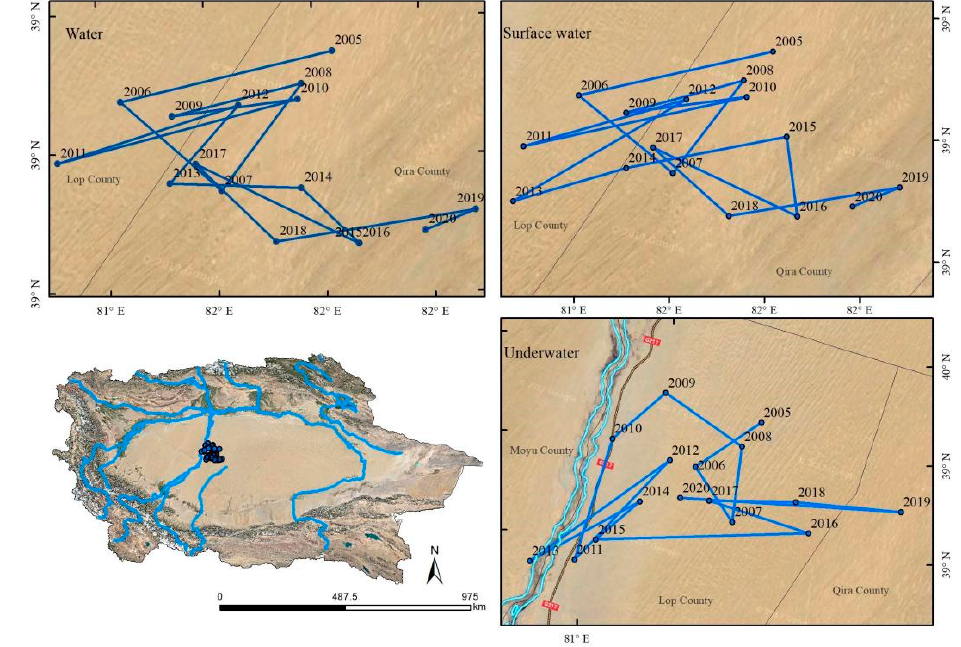
Figure 9. Evolutionary track of the CG of water resources in the Tarim River Basin.